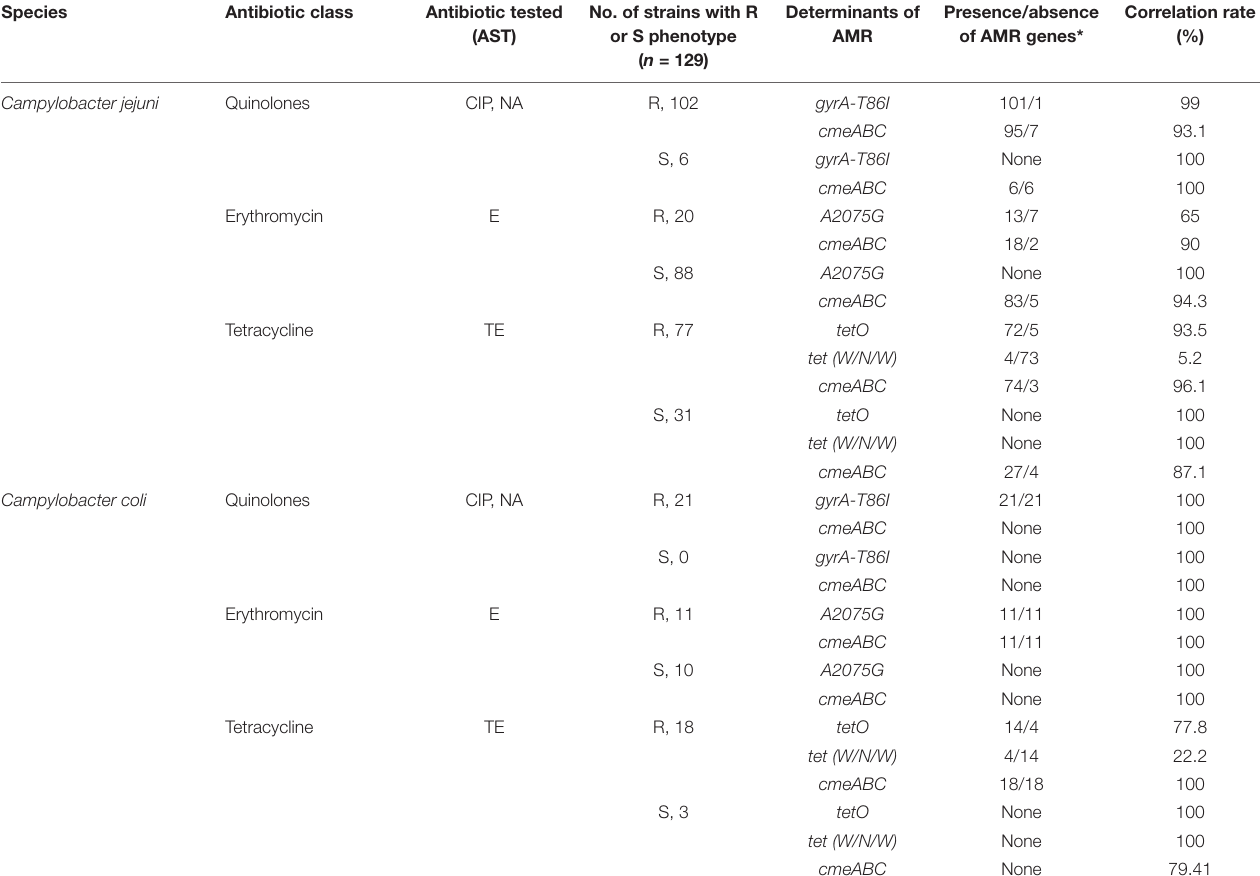
TABLE 4 | Correlations of resistance phenotype and genotype in C. jejuni ( n = 108) and C. coli ( n = 21) strains.